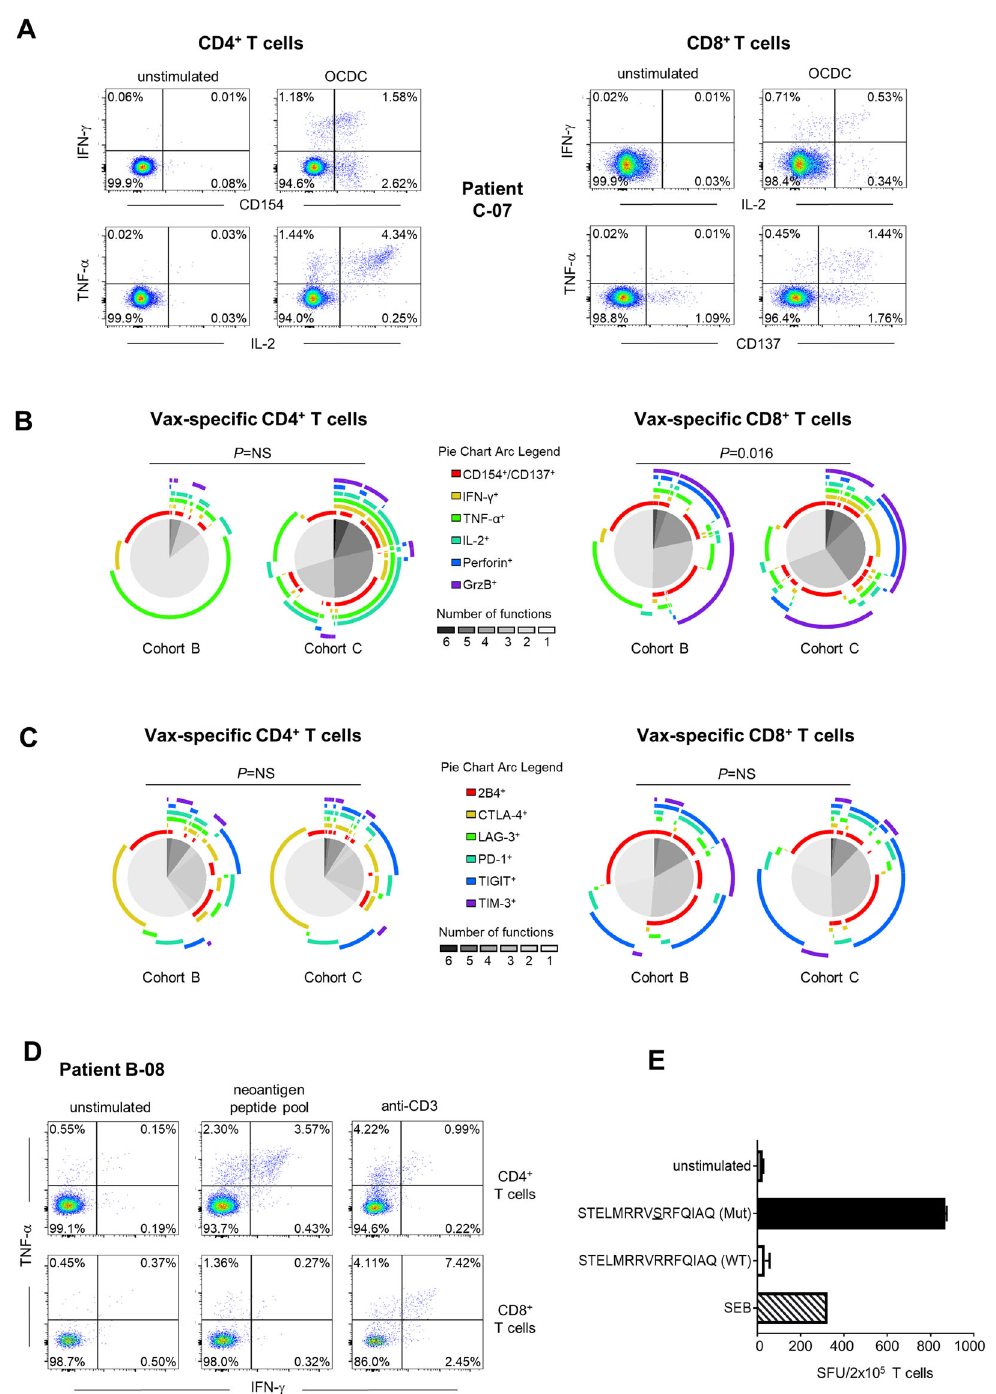
Fig. 2 The addition of ASA and low-dose IL-2 to an OCDC-Bev-Cy combinatorial regimen elicits polyfunctional T-cell responses in OC patients. A Examples in patient C-07 of polyfunctional OCDC vaccine-speci fi c CD4 + and CD8 + T-cell responses elicited. B Cumulative functional pro fi ling of OCDC vaccine-speci fi c CD4 + and CD8 + T-cell responses where cytokine-producing T cells (as shown in ( A )) in response to ex vivo OCDC stimulation were evaluated for (co)expressions of different functional markers as illustrated by the colored arcs. Pie charts represented in shades of gray depicting the number of markers coexpressed by OCDC vaccine-speci fi c T cells in Cohort B and C patients ( n = 6 patients per cohort). C Cytokine-producing CD4 + and CD8 + T cells following ex vivo OCDC stimulation were evaluated for (co)expression of the different activation/exhaustion markers as illustrated by the colored arcs. Pie charts in shades of gray depicted the number of markers coexpressed on the OCDC vaccine-speci fi c T cells in patients. N = 6 patients. D Identi fi cation of neoepitope-speci fi c CD4 + and CD8 + T-cell responses in Cohort B-08 patient. Neoepitopes from the peptide pool were described in Supplementary Table S1. E Bar charts showed the validation of the IFN- γ ELISpot T-cell response against the (STELMRRVSRFQIAQ [Mut]) neoepitope as well as the lack of response against the wild-type (STELMRRVRRFQIAQ [WT]) cognate peptide. P values for SPICE pies were determined with Wilcoxon rank-sum test. P < 0.05 was considered signi fi cant, while P > 0.05 was not signi fi cant